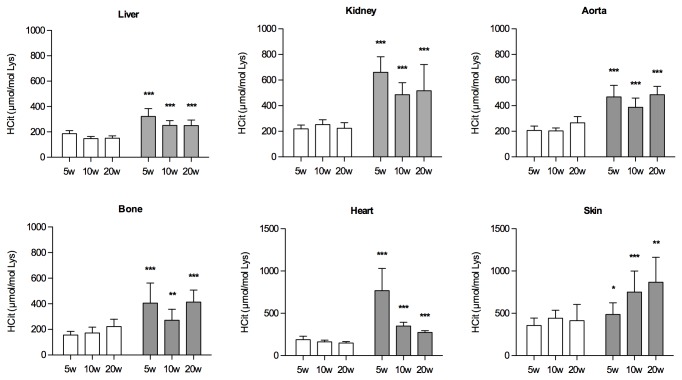
Carbamylated protein content of tissues.The carbamylated protein content of tissues is shown at 5, 10 and 20 weeks after surgery in CKD (grey bars) and sham-operated mice (white bars). Each bar represents the mean value of the 10 mice in the group. CP concentration is expressed as the ratio of homocitrulline (μmol) to lysine (mol). Mann-Whitney U test: *: p < 0.05; **: p < 0.01; ***: p < 0.001.